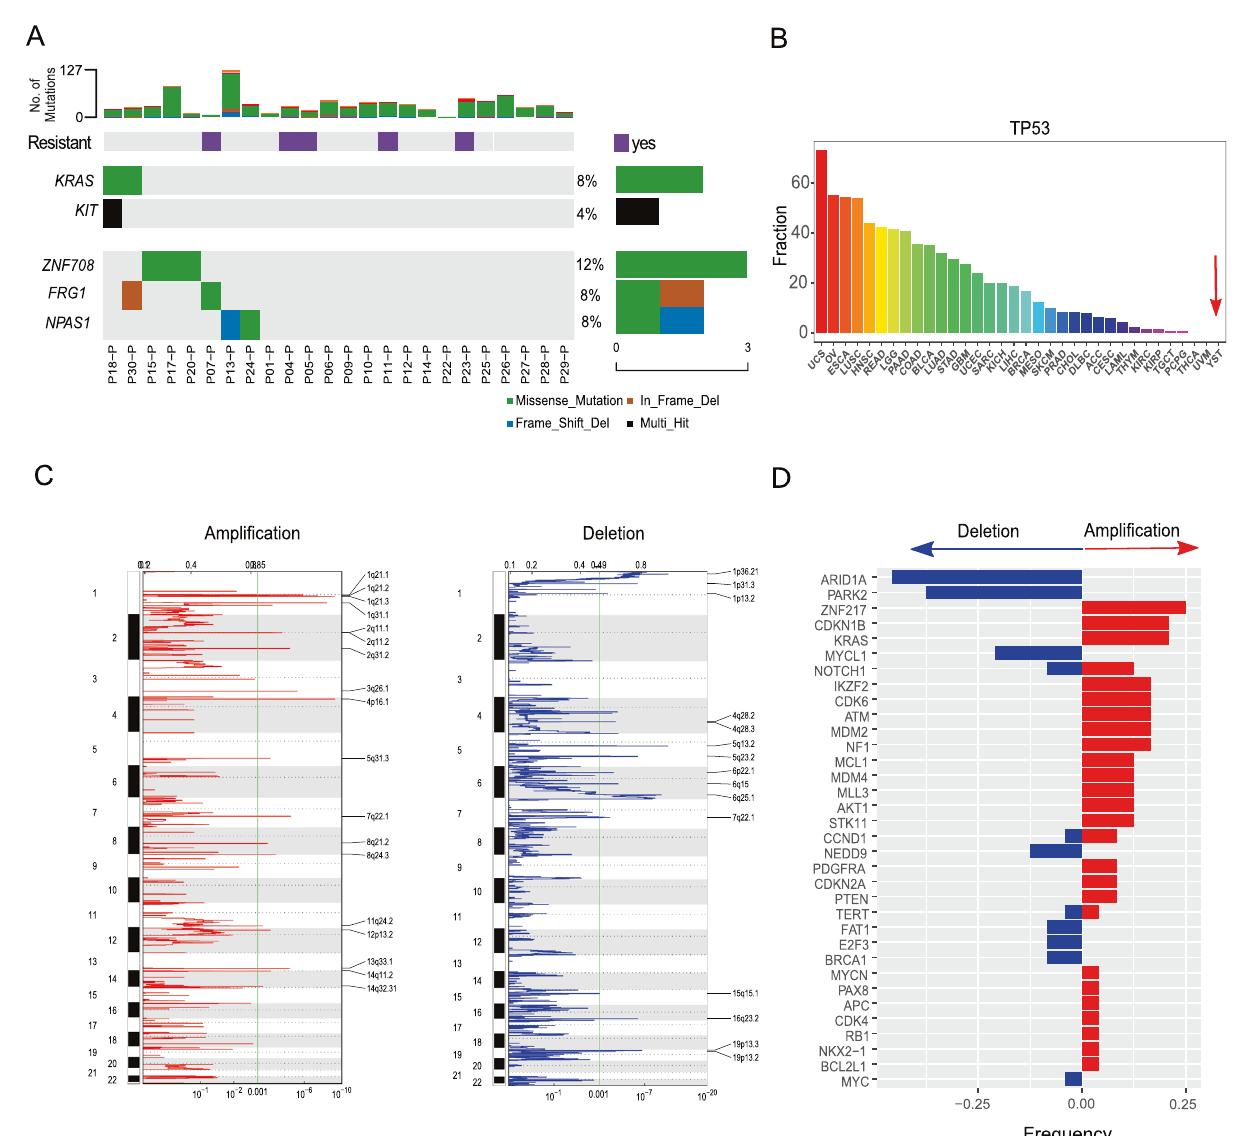
Fig. 3 The somatic alteration patterns of YST primary tumors. A Signi fi cantly mutated genes (SMGs) in all YST primary tumors ( n = 24) except for those from patients P02 and P03, with gonadal dysgenesis. The bars on the top and the right show the mutational rate observed for each tumor and the composition of mutations in selected genes, respectively. Two known cancer driver genes are in bold, and three driver candidates were identi fi ed by both MuSiC2 and MutSigCV. B The comparison of TP53 missense mutation frequencies in YST and 33 TCGA cancer types. C Ampli fi cation and deletion signals identi fi ed in YST. The segmentation data from the 24 YST primary samples were pooled for GISTIC2 analysis. Signi fi cantly ampli fi ed (left panel) or deleted (right panel) peaks were identi fi ed at FDR = 10 − 3 . The top and bottom numerical values refer to G-scores and q values, respectively. D The copy-number alteration frequencies of cancer drivers across primary YST